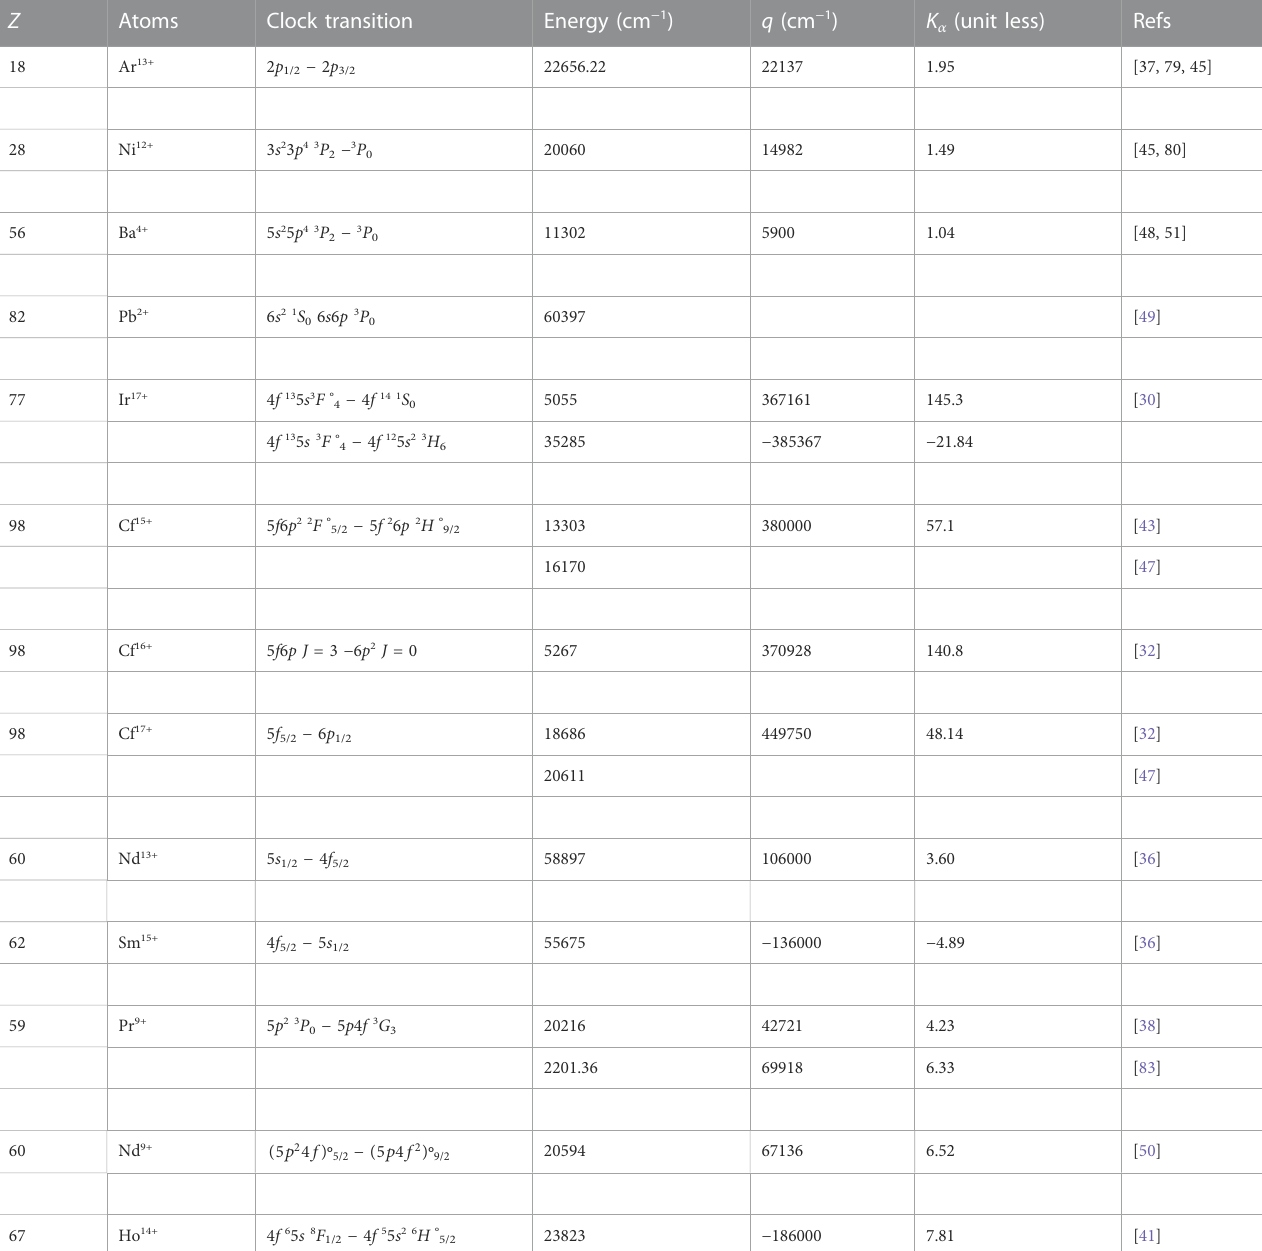
TABLE 4 A summary of the HCIs proposed for making optical clocks. The de fi nition of q and K α is given in text. Z Atoms Clock